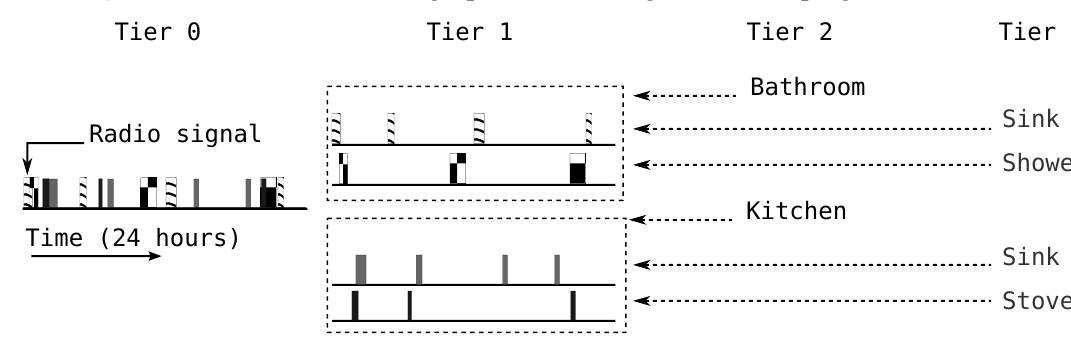
Figure 1. Four tiers of the fingerprint and timing-based snooping (FATS)